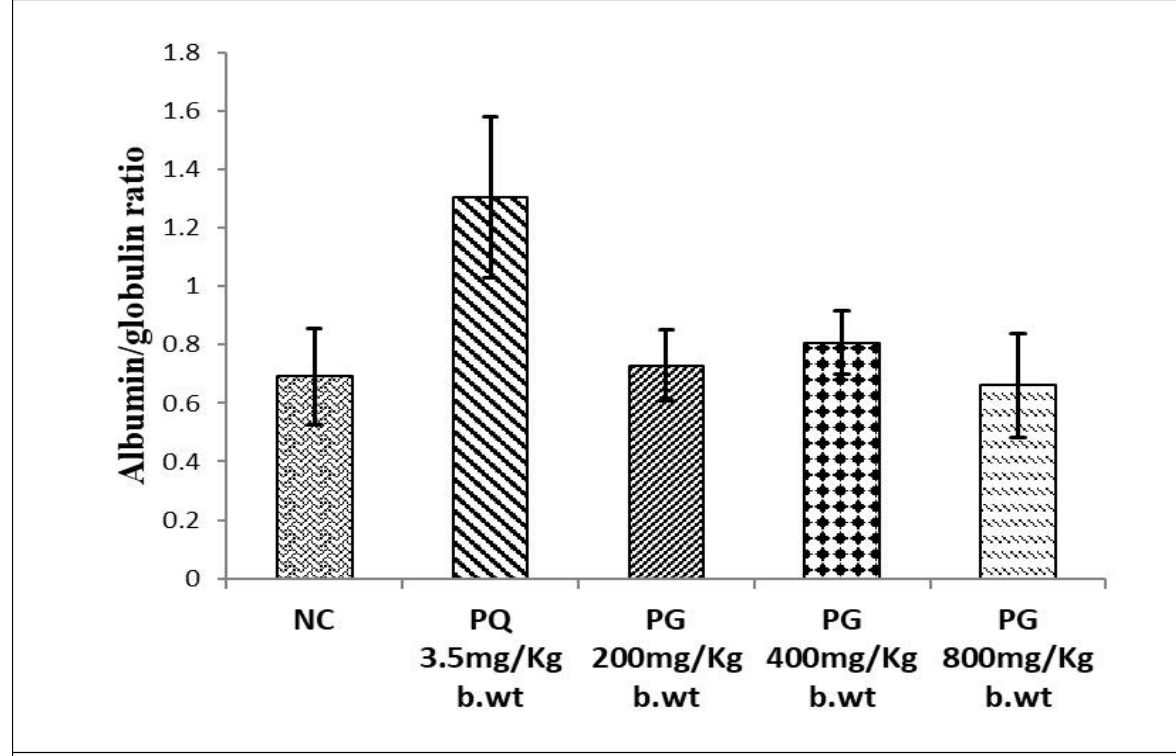
Figure 6: Effect of Psidium guajava leaf extract administration on serum albumin/globulin ratio of male Wistar albino rats administered 3.5 mg/kg b.wt. Paraquat